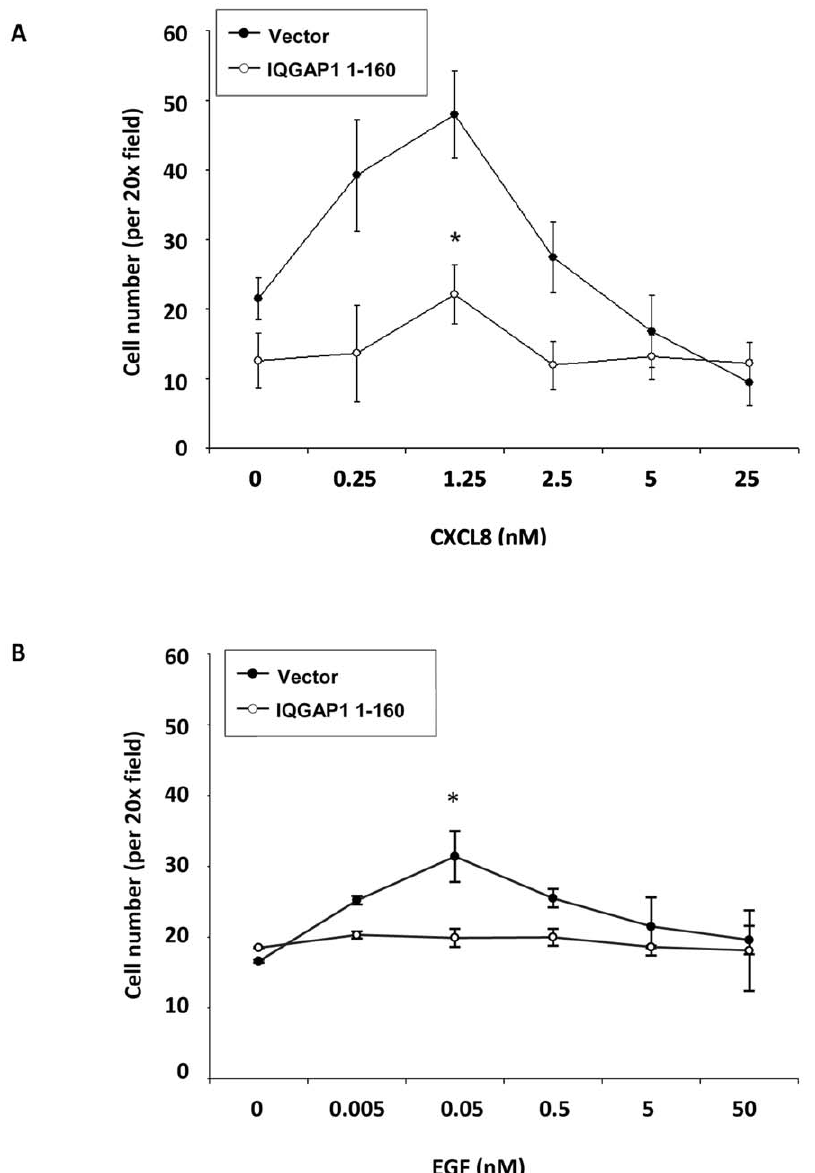
Figure 6. Boyden chamber assay assessing chemotaxis of HEK293-CXCR2 cells stably expressing empty vector or IQGAP1 1–160. HEK293-CXCR2 cells, with IQGAP1 1-160 and without (vector only) were stimulated with CXCL8 (A) or EGF (B) and assayed using a Boyden chamber to determine chemotaxis. A statistically significant difference between cells expressing vector and IQGAP1 1-160 was found and is represented by the asterisk (p-value , 0.001 (A) and =0.0111 (B); ANOVA). Graph represents the average cell number per 20X field 6 s.e.m. and is representative of three separate experiments.